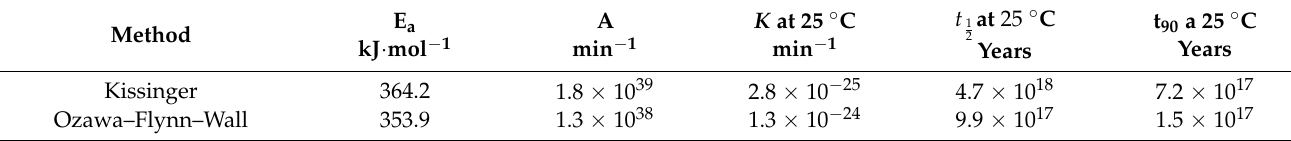
Figure 8: Experimental data points plotted according to the Ozawa-Flynn-Wall method and their linear regression. Table S1: Data used to determine the Kissinger equation, Figure S2: Data used to determine the Ozawa-Flynn-Wall